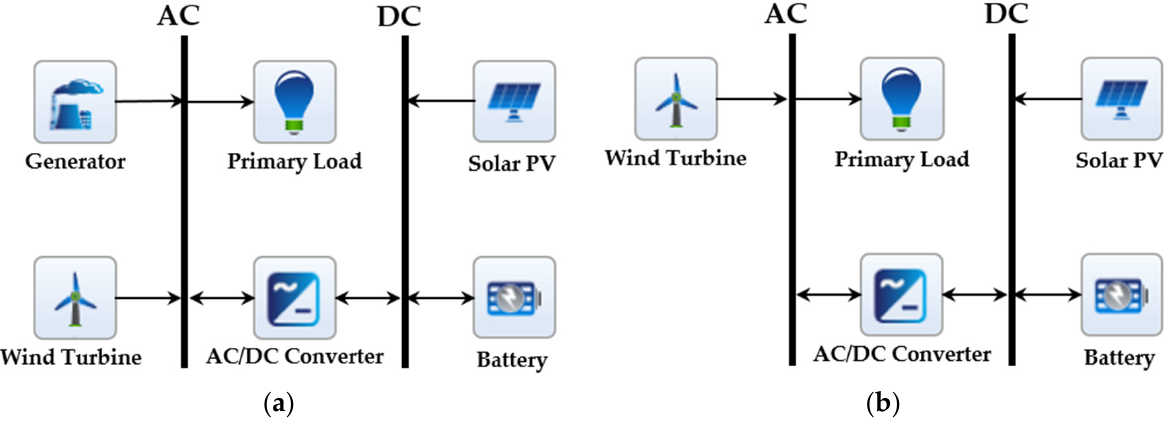
Figure 6. Schematic diagrams of ( a ) configuration 1: hybrid diesel–solar PV–wind–battery for MTS; ( b ) configuration 2: hybrid solar PV–wind–battery for ATS.